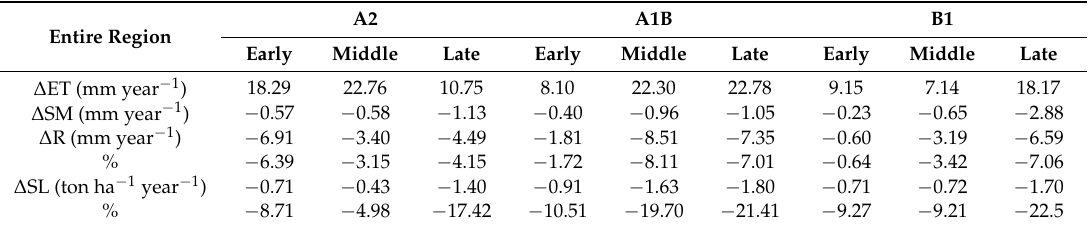
Table 5. Annual changes of ET, soil moisture, runoff, and soil loss of the entire Great Lakes region over three future periods under three SRES scenarios.